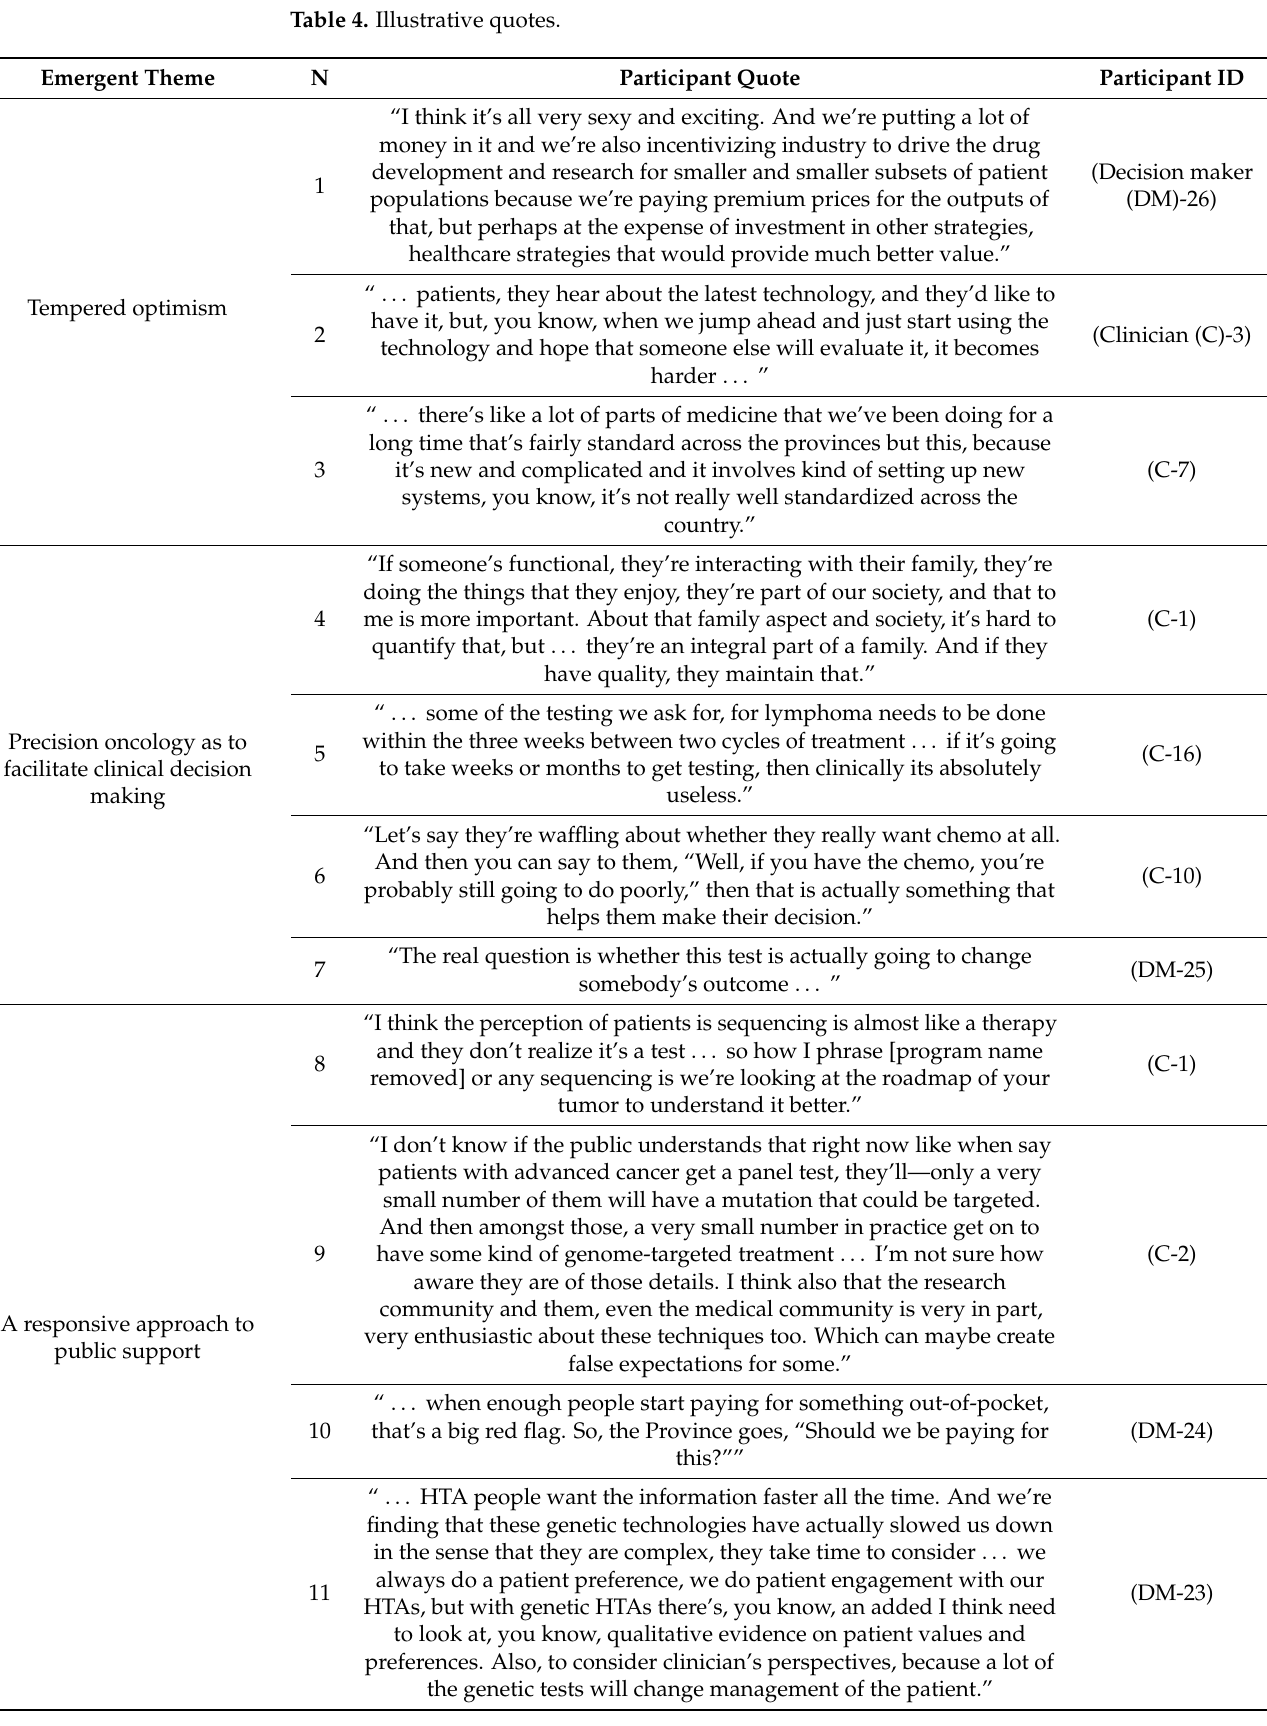
Table 4. Illustrative